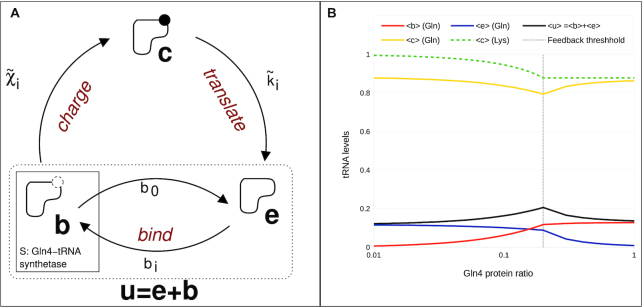
Analysis of the levels of free tRNA in a synthetase-depleted strain using model simulation. Panel A; Synthetase sequestration model for tRNAs: When we measure uncharged tRNA, some of it is synthetase-associated, captured mid-reaction, but still uncharged. Hence, two intermediate states are introduced: the ‘bound’ state \documentclass[12pt]{minimal}
\usepackage{amsmath}
\usepackage{wasysym}
\usepackage{amsfonts}
\usepackage{amssymb}
\usepackage{amsbsy}
\usepackage{upgreek}
\usepackage{mathrsfs}
\setlength{\oddsidemargin}{-69pt}
\begin{document}
}{}$( b )$\end{document}, and the ‘empty’ state \documentclass[12pt]{minimal}
\usepackage{amsmath}
\usepackage{wasysym}
\usepackage{amsfonts}
\usepackage{amssymb}
\usepackage{amsbsy}
\usepackage{upgreek}
\usepackage{mathrsfs}
\setlength{\oddsidemargin}{-69pt}
\begin{document}
}{}$( e )$\end{document}; the tRNA with amino acid is in the ‘charged’ state \documentclass[12pt]{minimal}
\usepackage{amsmath}
\usepackage{wasysym}
\usepackage{amsfonts}
\usepackage{amssymb}
\usepackage{amsbsy}
\usepackage{upgreek}
\usepackage{mathrsfs}
\setlength{\oddsidemargin}{-69pt}
\begin{document}
}{}$( c )$\end{document}. The transition from the empty state to the bound state, during which the synthetase associates with the tRNA at the binding rate \documentclass[12pt]{minimal}
\usepackage{amsmath}
\usepackage{wasysym}
\usepackage{amsfonts}
\usepackage{amssymb}
\usepackage{amsbsy}
\usepackage{upgreek}
\usepackage{mathrsfs}
\setlength{\oddsidemargin}{-69pt}
\begin{document}
}{}${b_i}$\end{document}, depends on the synthetase concentration \documentclass[12pt]{minimal}
\usepackage{amsmath}
\usepackage{wasysym}
\usepackage{amsfonts}
\usepackage{amssymb}
\usepackage{amsbsy}
\usepackage{upgreek}
\usepackage{mathrsfs}
\setlength{\oddsidemargin}{-69pt}
\begin{document}
}{}$[ {{E_i}} ]$\end{document}, and the number of ‘empty’ tRNAs \documentclass[12pt]{minimal}
\usepackage{amsmath}
\usepackage{wasysym}
\usepackage{amsfonts}
\usepackage{amssymb}
\usepackage{amsbsy}
\usepackage{upgreek}
\usepackage{mathrsfs}
\setlength{\oddsidemargin}{-69pt}
\begin{document}
}{}$T_i^e$\end{document} of amino acid of type \documentclass[12pt]{minimal}
\usepackage{amsmath}
\usepackage{wasysym}
\usepackage{amsfonts}
\usepackage{amssymb}
\usepackage{amsbsy}
\usepackage{upgreek}
\usepackage{mathrsfs}
\setlength{\oddsidemargin}{-69pt}
\begin{document}
}{}$i$\end{document}. The reverse transition \documentclass[12pt]{minimal}
\usepackage{amsmath}
\usepackage{wasysym}
\usepackage{amsfonts}
\usepackage{amssymb}
\usepackage{amsbsy}
\usepackage{upgreek}
\usepackage{mathrsfs}
\setlength{\oddsidemargin}{-69pt}
\begin{document}
}{}${b_0}$\end{document}describes the dissociation of the synthetase-tRNA complex and therefore depends on the number \documentclass[12pt]{minimal}
\usepackage{amsmath}
\usepackage{wasysym}
\usepackage{amsfonts}
\usepackage{amssymb}
\usepackage{amsbsy}
\usepackage{upgreek}
\usepackage{mathrsfs}
\setlength{\oddsidemargin}{-69pt}
\begin{document}
}{}$T_i^b$\end{document}of ‘bound’ tRNAs. The transition from ‘bound’ (b) to ‘charged’ (c) state occurs at rate \documentclass[12pt]{minimal}
\usepackage{amsmath}
\usepackage{wasysym}
\usepackage{amsfonts}
\usepackage{amssymb}
\usepackage{amsbsy}
\usepackage{upgreek}
\usepackage{mathrsfs}
\setlength{\oddsidemargin}{-69pt}
\begin{document}
}{}${\tilde{\chi }_i}$\end{document}, and it is affiliated with the catalytic rate \documentclass[12pt]{minimal}
\usepackage{amsmath}
\usepackage{wasysym}
\usepackage{amsfonts}
\usepackage{amssymb}
\usepackage{amsbsy}
\usepackage{upgreek}
\usepackage{mathrsfs}
\setlength{\oddsidemargin}{-69pt}
\begin{document}
}{}${k_{cat,i}}$\end{document} and it also depends on the number \documentclass[12pt]{minimal}
\usepackage{amsmath}
\usepackage{wasysym}
\usepackage{amsfonts}
\usepackage{amssymb}
\usepackage{amsbsy}
\usepackage{upgreek}
\usepackage{mathrsfs}
\setlength{\oddsidemargin}{-69pt}
\begin{document}
}{}$T_i^b$\end{document}of ‘bound’ tRNAs. The transition between the ‘charged’ (c) and the ‘empty’ (e) state is governed by the doxycycline sensitive hopping rate \documentclass[12pt]{minimal}
\usepackage{amsmath}
\usepackage{wasysym}
\usepackage{amsfonts}
\usepackage{amssymb}
\usepackage{amsbsy}
\usepackage{upgreek}
\usepackage{mathrsfs}
\setlength{\oddsidemargin}{-69pt}
\begin{document}
}{}${\tilde{k}_i}$\end{document}, incorporating the feedback, and it depends on the number \documentclass[12pt]{minimal}
\usepackage{amsmath}
\usepackage{wasysym}
\usepackage{amsfonts}
\usepackage{amssymb}
\usepackage{amsbsy}
\usepackage{upgreek}
\usepackage{mathrsfs}
\setlength{\oddsidemargin}{-69pt}
\begin{document}
}{}$T_i^c$\end{document}of ‘charged’ tRNAs. Panel B; Resulting plot of the steady state charging levels of the glutamine tRNAs as a function of the Gln4 protein ratio; using the Gillespie algorithm, the three-state-network of all 20 amino acids was simulated for different doxycycline factors. Yellow line: mean level \documentclass[12pt]{minimal}
\usepackage{amsmath}
\usepackage{wasysym}
\usepackage{amsfonts}
\usepackage{amssymb}
\usepackage{amsbsy}
\usepackage{upgreek}
\usepackage{mathrsfs}
\setlength{\oddsidemargin}{-69pt}
\begin{document}
}{}$\langle c \rangle$\end{document} of charged glutamine tRNAs; red line: mean level \documentclass[12pt]{minimal}
\usepackage{amsmath}
\usepackage{wasysym}
\usepackage{amsfonts}
\usepackage{amssymb}
\usepackage{amsbsy}
\usepackage{upgreek}
\usepackage{mathrsfs}
\setlength{\oddsidemargin}{-69pt}
\begin{document}
}{}$\langle b \rangle$\end{document} of bound glutamine tRNAs; blue line: mean level \documentclass[12pt]{minimal}
\usepackage{amsmath}
\usepackage{wasysym}
\usepackage{amsfonts}
\usepackage{amssymb}
\usepackage{amsbsy}
\usepackage{upgreek}
\usepackage{mathrsfs}
\setlength{\oddsidemargin}{-69pt}
\begin{document}
}{}$\langle e \rangle$\end{document} of empty glutamine tRNAs; Black line: mean level \documentclass[12pt]{minimal}
\usepackage{amsmath}
\usepackage{wasysym}
\usepackage{amsfonts}
\usepackage{amssymb}
\usepackage{amsbsy}
\usepackage{upgreek}
\usepackage{mathrsfs}
\setlength{\oddsidemargin}{-69pt}
\begin{document}
}{}$\langle u \rangle = \langle e \rangle \ + \langle b \rangle$\end{document} of uncharged glutamine tRNAs; green dashed line: mean level of charged lysine tRNAs. The grey dashed line indicates the feedback threshold \documentclass[12pt]{minimal}
\usepackage{amsmath}
\usepackage{wasysym}
\usepackage{amsfonts}
\usepackage{amssymb}
\usepackage{amsbsy}
\usepackage{upgreek}
\usepackage{mathrsfs}
\setlength{\oddsidemargin}{-69pt}
\begin{document}
}{}$d = 0.2$\end{document}: for Gln4 protein ratios smaller than 0.2 the usage rate decreases analogously to the growth rate.